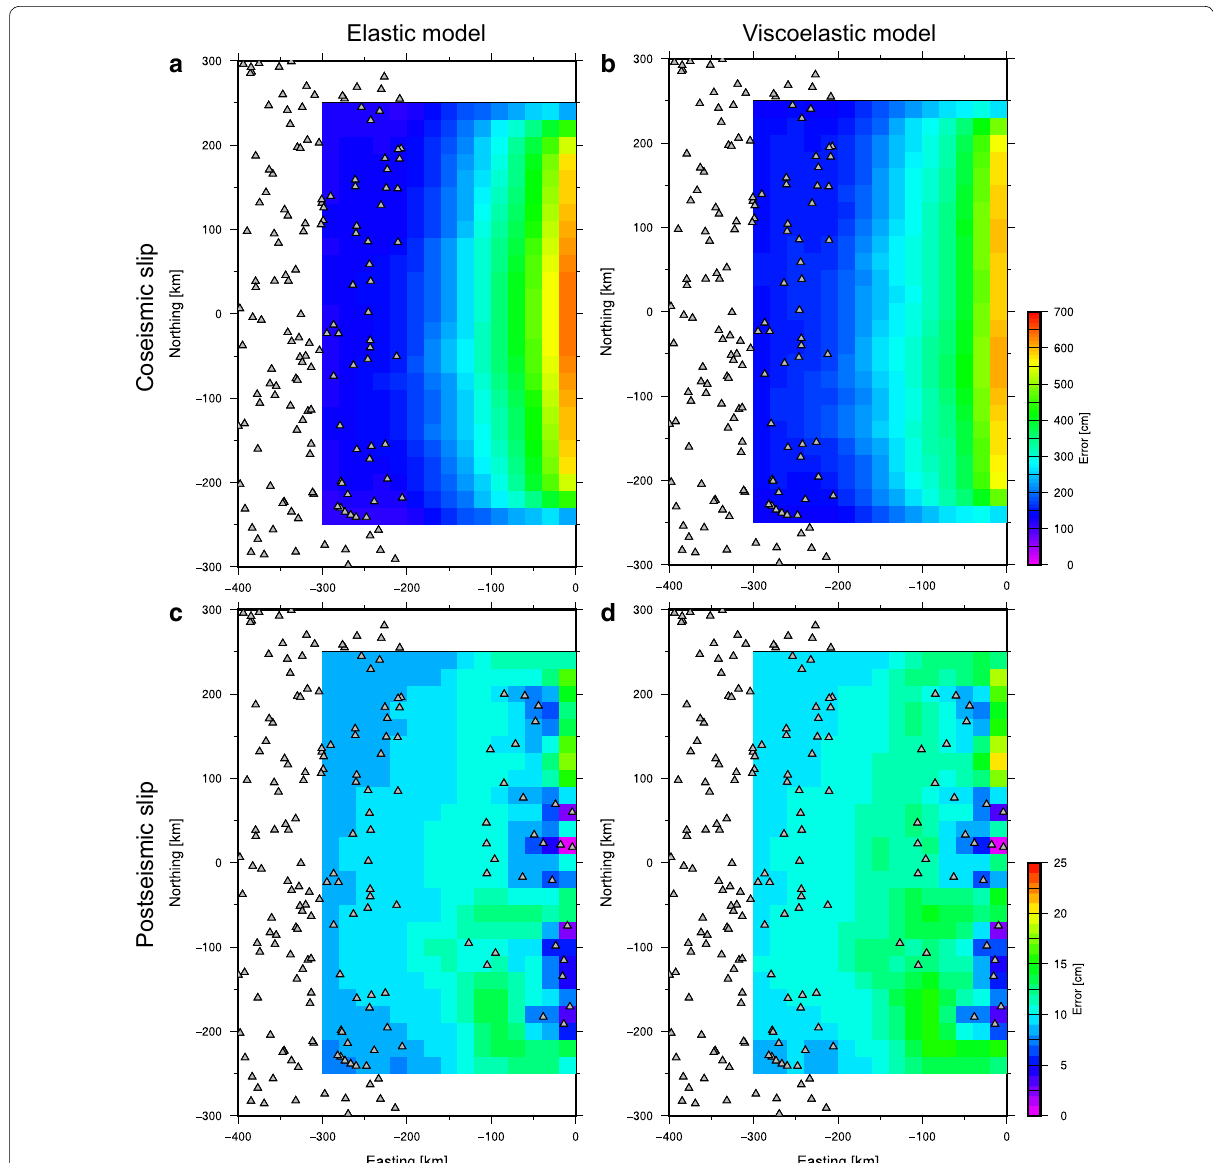
Fig. 8 Estimation errors for the dip–slip case. a , c The estimation errors of the co- and post-seismic slip distributions in the elastic model for the dip–slip case, respectively. b , d The estimation errors of the co- and post-seismic slip distributions in the viscoelastic model for the dip–slip case, respectively. Gray triangles show the same as with Fig.